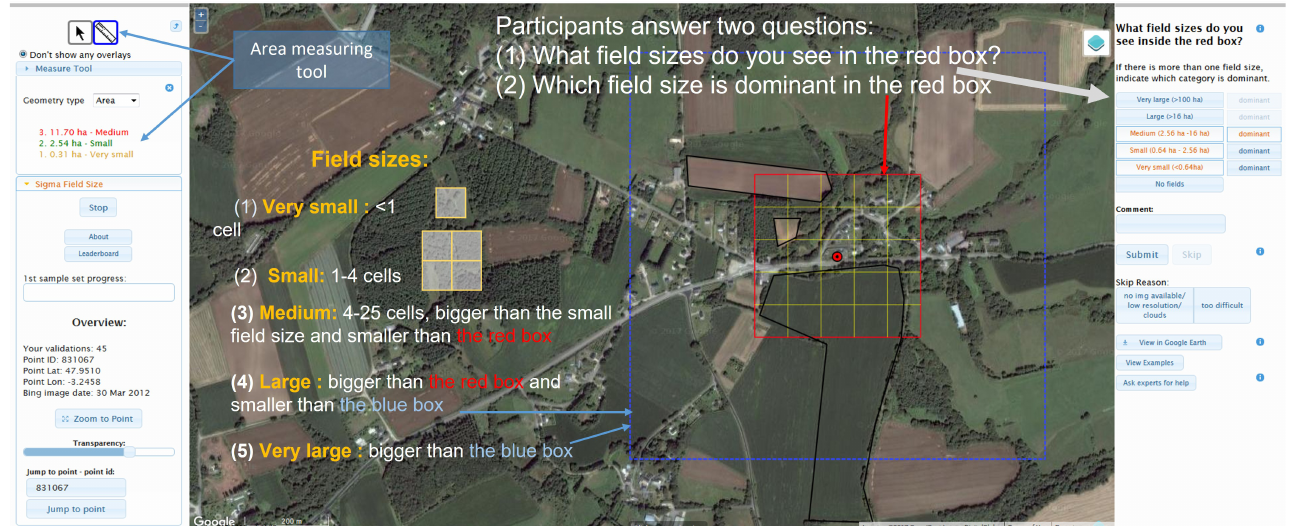
Figure 6. The Geo-Wiki interface for the identification of agricultural field size showing the questions that volunteers need to answer, the area measuring tool and guidance on how to estimate field sizes using the grid squares. Source of imagery: